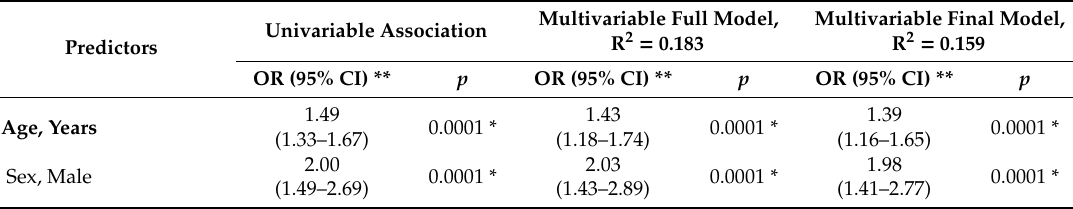
Table 6. Backward logistic regression analysis showing univariable and significant multivariable associations of predictors of not using the trails. The dependent variable was using vs. non-using the trails. All other variables were considered as independent